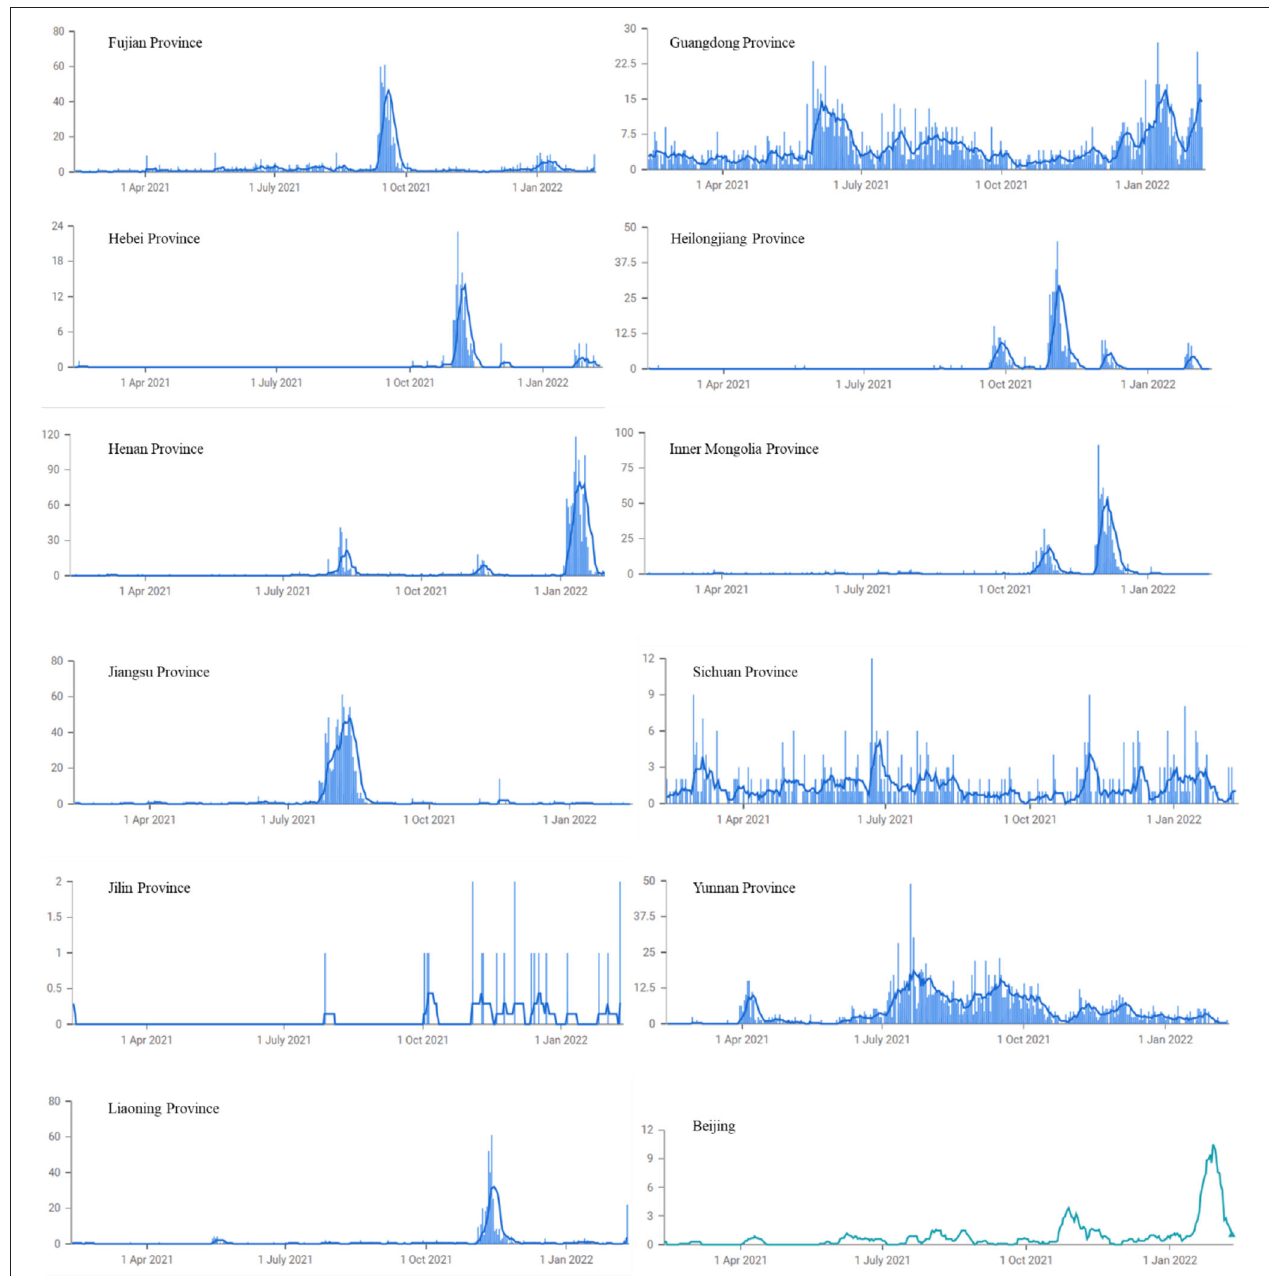
FIGURE 1 | COVID-19 waves in China since 2021. Data source: Our World in Data.